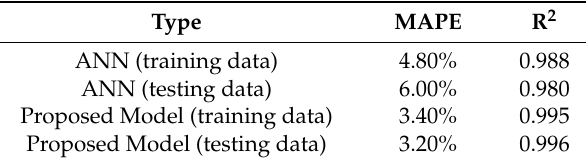
Table 3. Comparison of prediction accuracy between the proxy model and ANN.